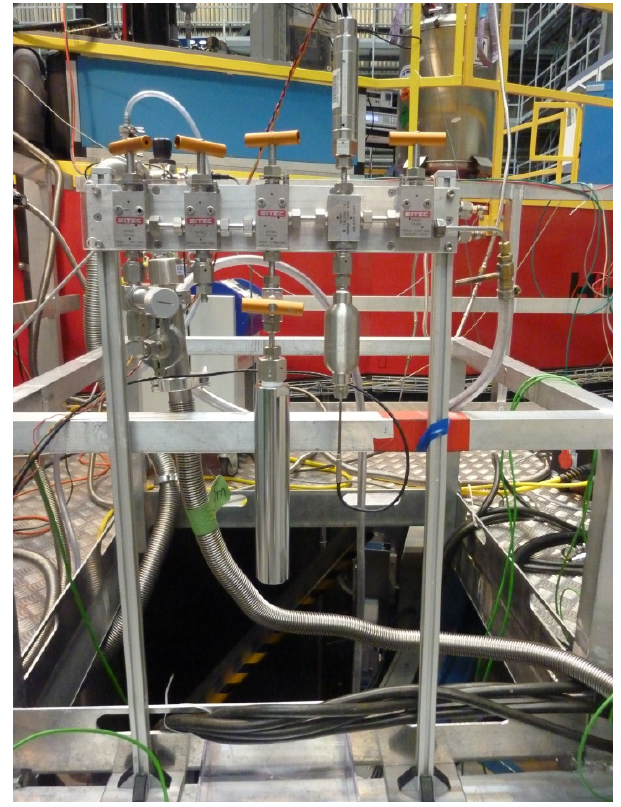
Figure 3. High pressure synthesis setup for the in situ NPD measurements at pressures up to 1000 bar D 2